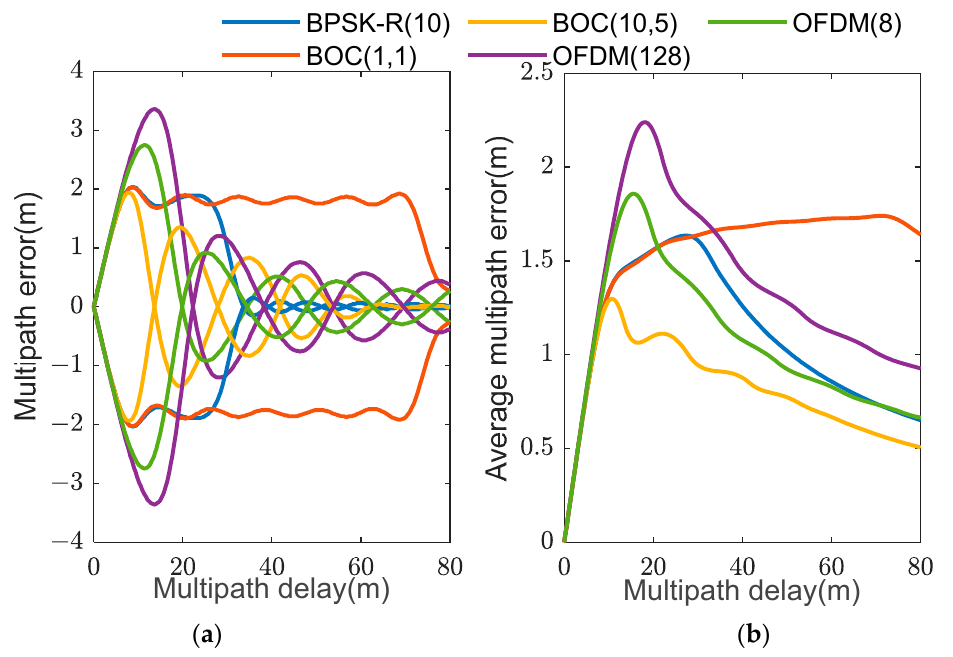
Figure 14. Multipath error of the navigation signal. ( a ) Multipath envelope error; ( b ) Multipath envelope average error.